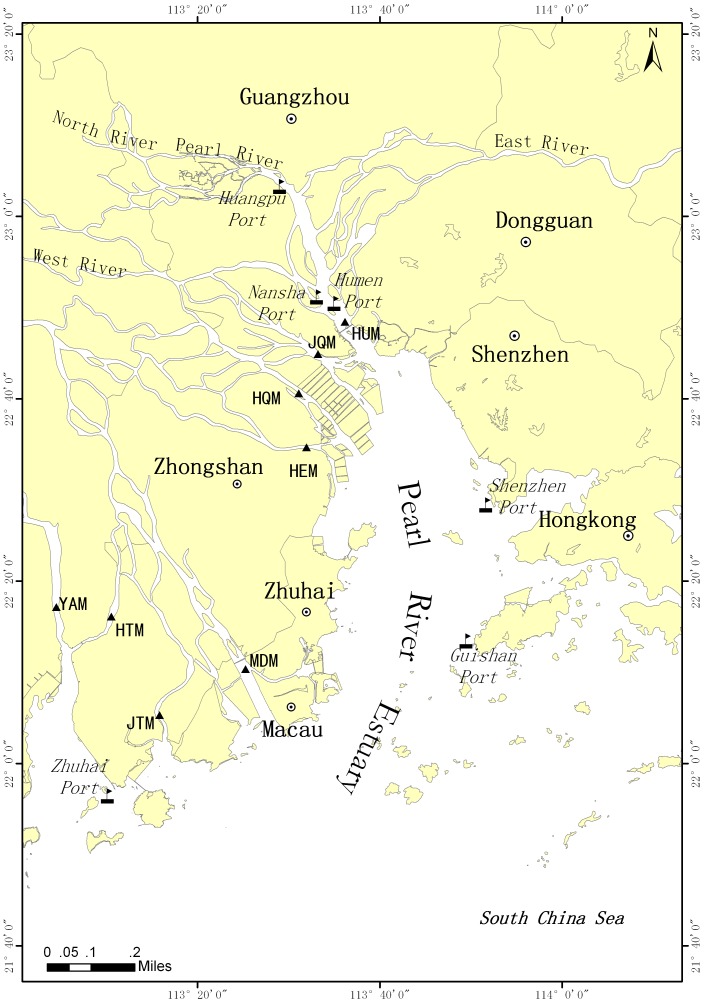
Map of Pearl River Estuary.